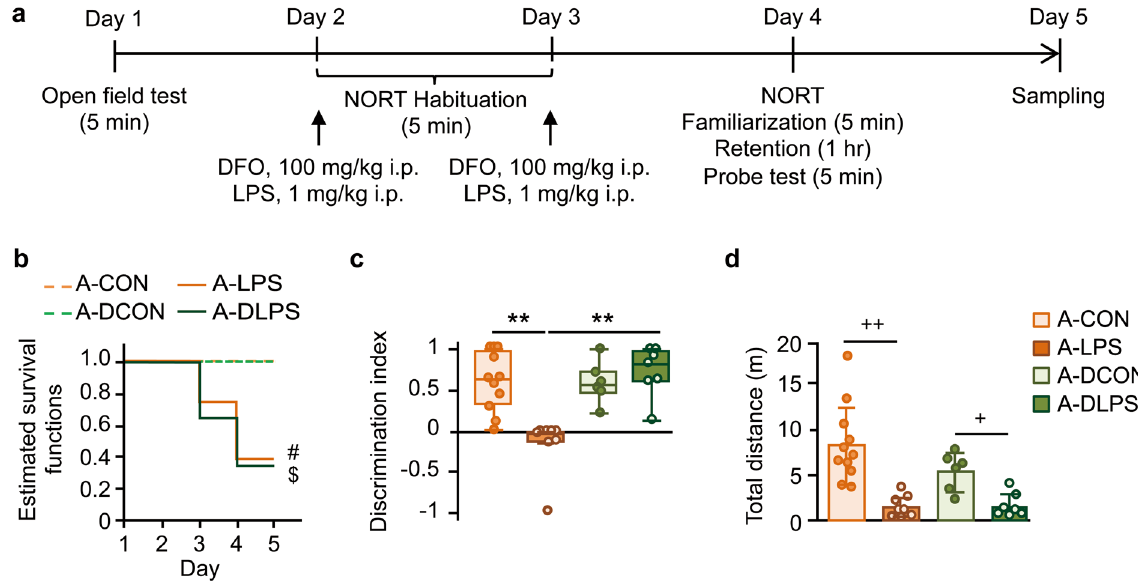
Figure 3. Deferoxamine (DFO) pretreatment blocked LPS-induced impairment of object discrimination in aged rats. ( a ) Aged rats were assigned to the 100 mg/kg DFO intraperitoneal treatment or 1 mg/kg LPS injection with DFO pretreatment group (A-DCON, n = 6, or A-DLPS, n = 20). DFO was administered 1 h before LPS injections. Details of the A-CON and A-LPS groups were as in Fig. 1. ( b ) The survival rate of the A-DLPS group was significantly lower than that of the A-DCON group. There was no significant difference between the survival rates of the A-LPS and A-DLPS groups. ( c ) In the NORT, A-DLPS group rats showed a higher discrimination index than A-LPS group rats. ( d ) DFO pretreatment did not attenuate the LPS-induced reduction of locomotion in the NORT. The behavioral data are presented as the median ± IQR or mean ± SD. A-CON, n = 11; A-LPS, n = 8; A-DCON, n = 6; A-DLPS, n = 7. Log-rank test with Bonferroni correction: # P < 0.05, A-CON vs. A-LPS; $ P < 0.05, Welch’s ANOVA [F 3,14.1 = 12.8, P < 0.001, ω 2 = 0.66] and post-hoc Bonferroni corrected Welch’s t -test, + P <